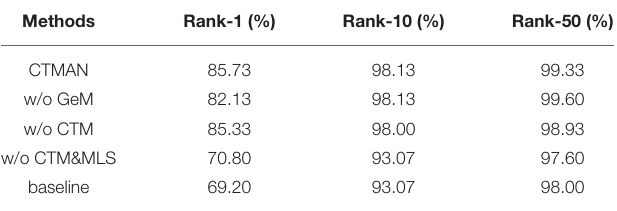
TABLE 3 | Results of the CTMAN, w/o GeM, w/o CTM, w/o CTM&MLS, and baseline on the S2 setup.